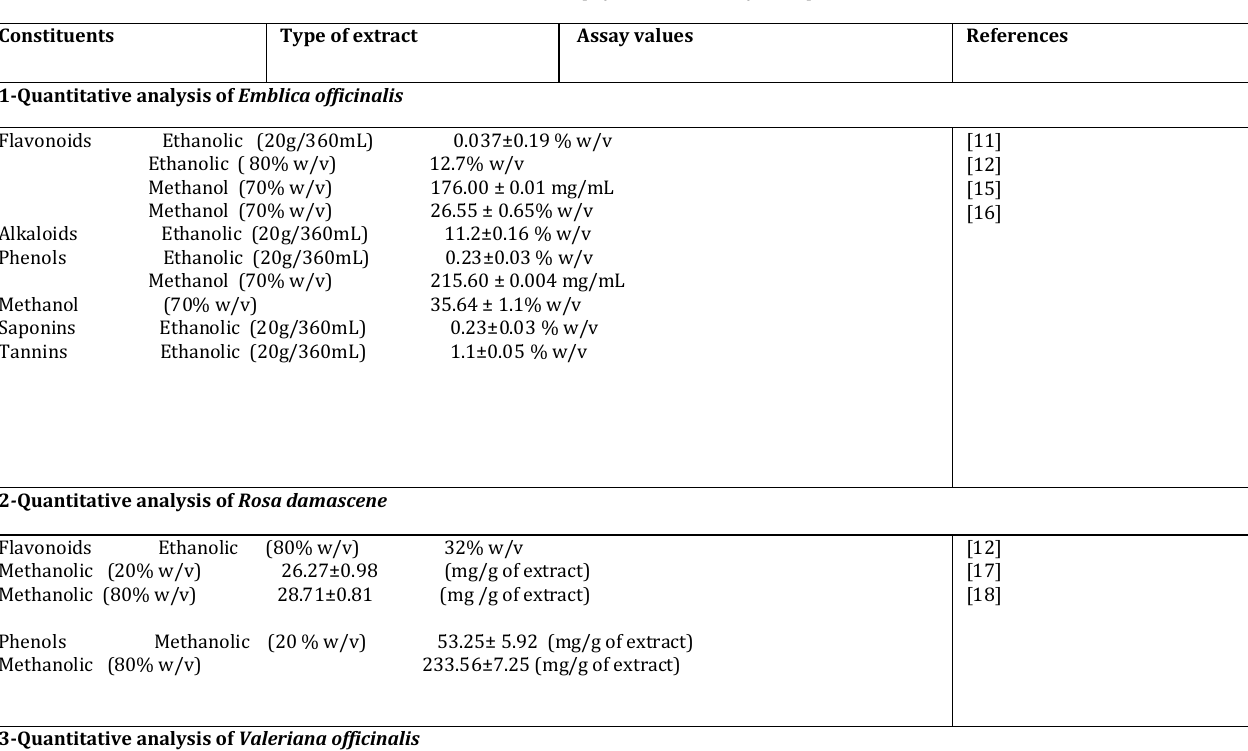
Table 2: Quantitative phytochemical analysis of